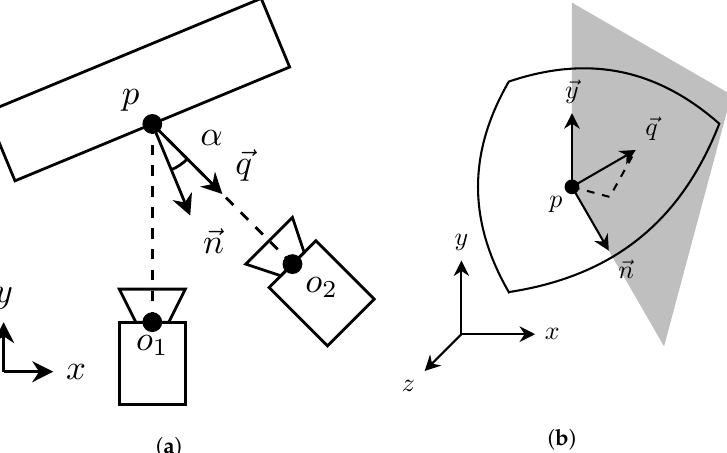
Figure 10. ( a ) Emission angle calculation for the point p . ( b ) Illustration of the vertical plane that splits the space along the direction of the point normal and the y axis. It is used for determining the sign of the emission